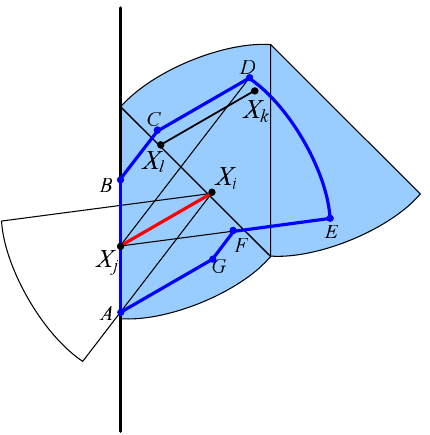
Figure 5. The proof of Theorem